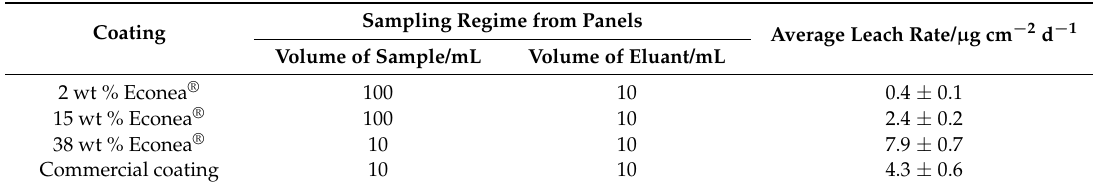
Table 1. Average leach rates of Econea ® from synthetic mixtures and a commercial coating. Sampling Regime from Panels Coating